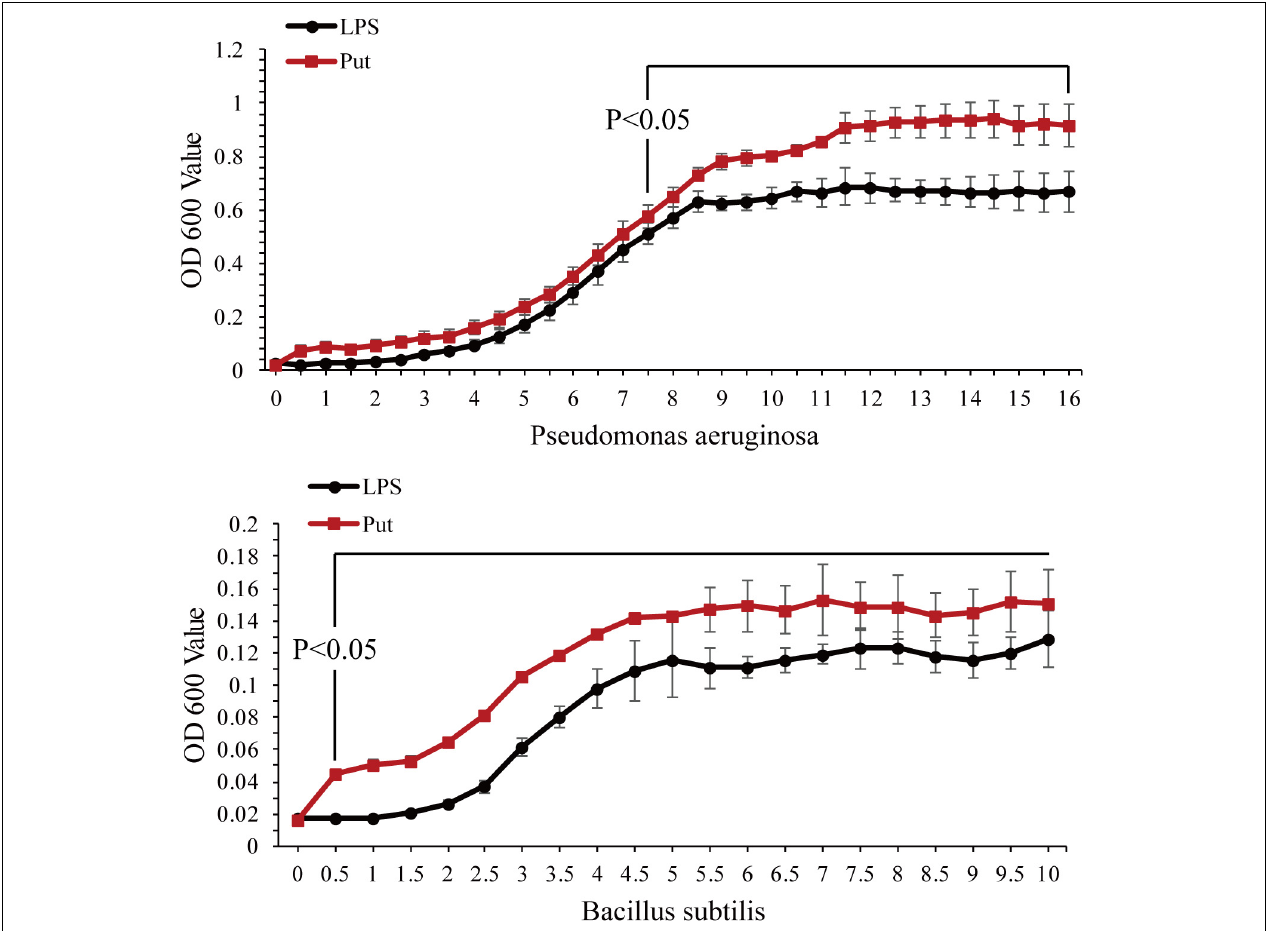
FIGURE 4 | Antibacterial activity of serum after the putrescine treatment. Values are shown as mean ± SE ( N = 5), and different superscripts indicate significant differences at P < 0.05. Lipopolysaccharide (LPS) group, PBS_LPS; Put group, Put dihydrochloride_LPS. Lowercase letters represent differences at different time points in the same groups, and capital letters represent differences in the different groups at same time